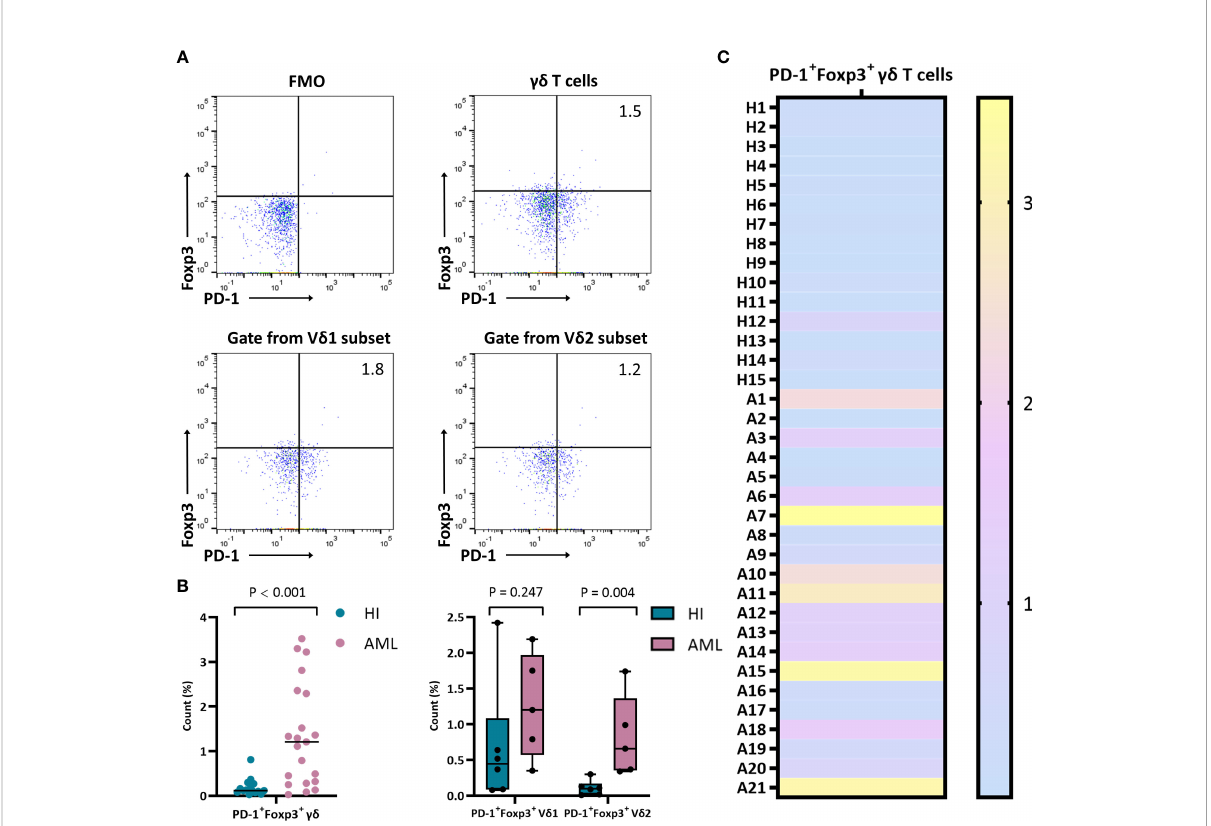
FIGURE 3 Distribution and frequency of co-expression with PD-1 and Foxp3 in gd , V d 1, and V d 2 cell subsets. (A) Detection of co-expression with PD-1 and Foxp3 in gd , V d 1, and V d 2 cell subsets from a patient with de novo AML by fl ow cytometry analysis. (B) Comparison of the percentage of PD- 1 + Foxp3 + in gd , V d 1, and V d 2 cell subsets from de novo AML patients compared with HIs. (C) Heatmap representing the frequency of the PD- 1 + Foxp3 + gd T subset in HIs (H1-H15) and patients with de novo AML